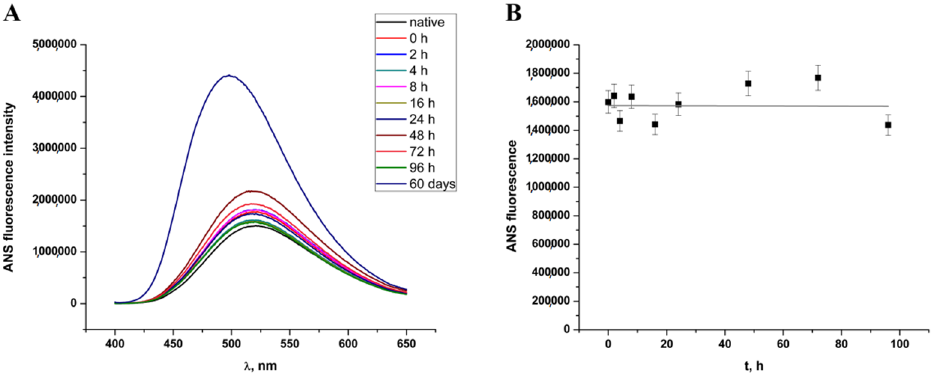
Figure 2. ( A ) 8-anilinonaphthalene-1-sulphonic acid (ANS) fluorescence spectra during four days’ HEWL incubation in 90% ethanol and after a 60-day incubation period. ( B ) Time-dependent change of ANS fluorescence during four days’ incubation of HEWL in 90% ethanol